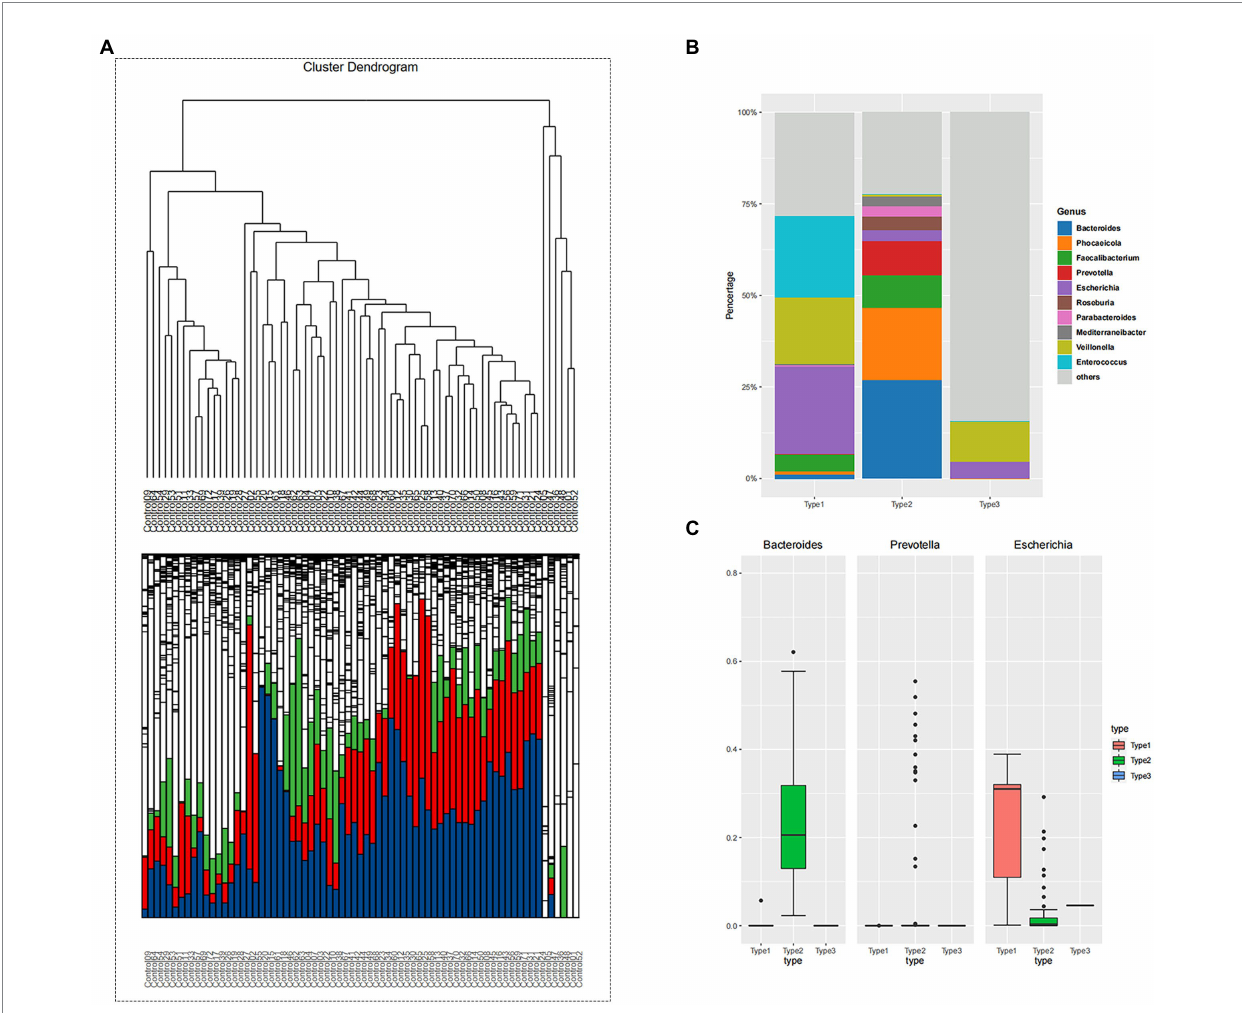
FIGURE 1 (A) The hierarchical clustering result of control group. The clustering results reflect the distance between the samples, allowing the samples to be divided into three distinct enterotypes and showing the relative abundance of the bacteria contained in the sample at the level of the genus contained in each branch. Enterotype- Escherichia : 19; Enterotype- Bacteroides : 46; Enterotype- Veroniella : 6. (blue: Bacteroides ; green: Faecalibacterium ; red: Prevotella ). (B) The samples were divided into three groups according to the clustering results of control group, and the top 10 genera contained in each group were displayed. Bacterial community of three enterotypes: a bacterial proportion in the three enterotypes. (C) The grouping box diagram shows the percentage content of the three bacterial genera in the three groups clustered by samples in control